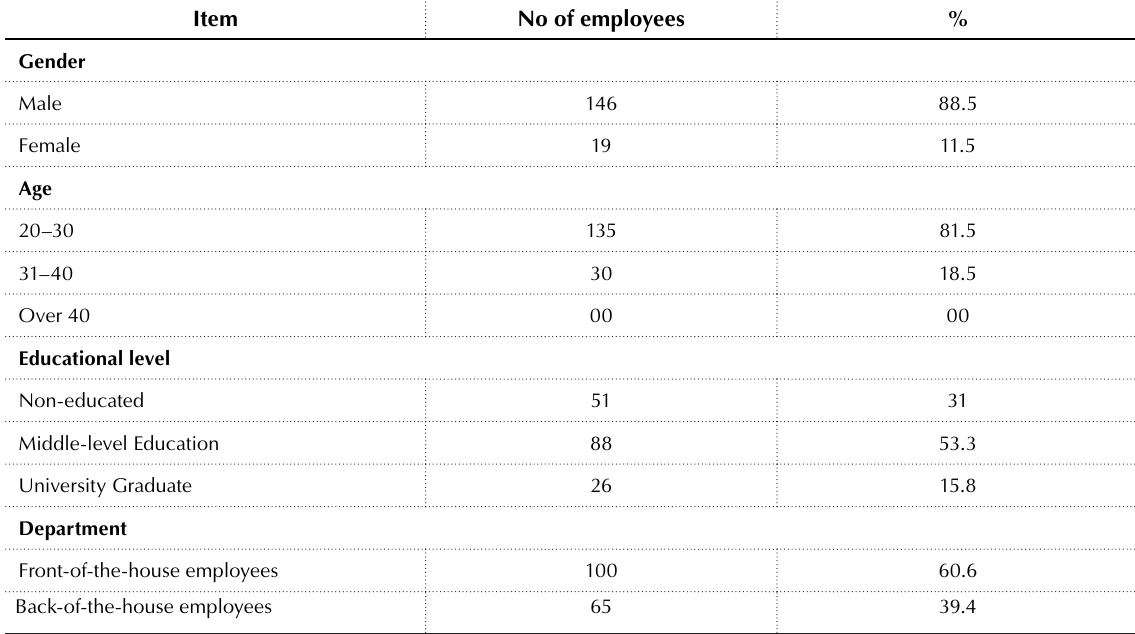
Table 3. Respondents’